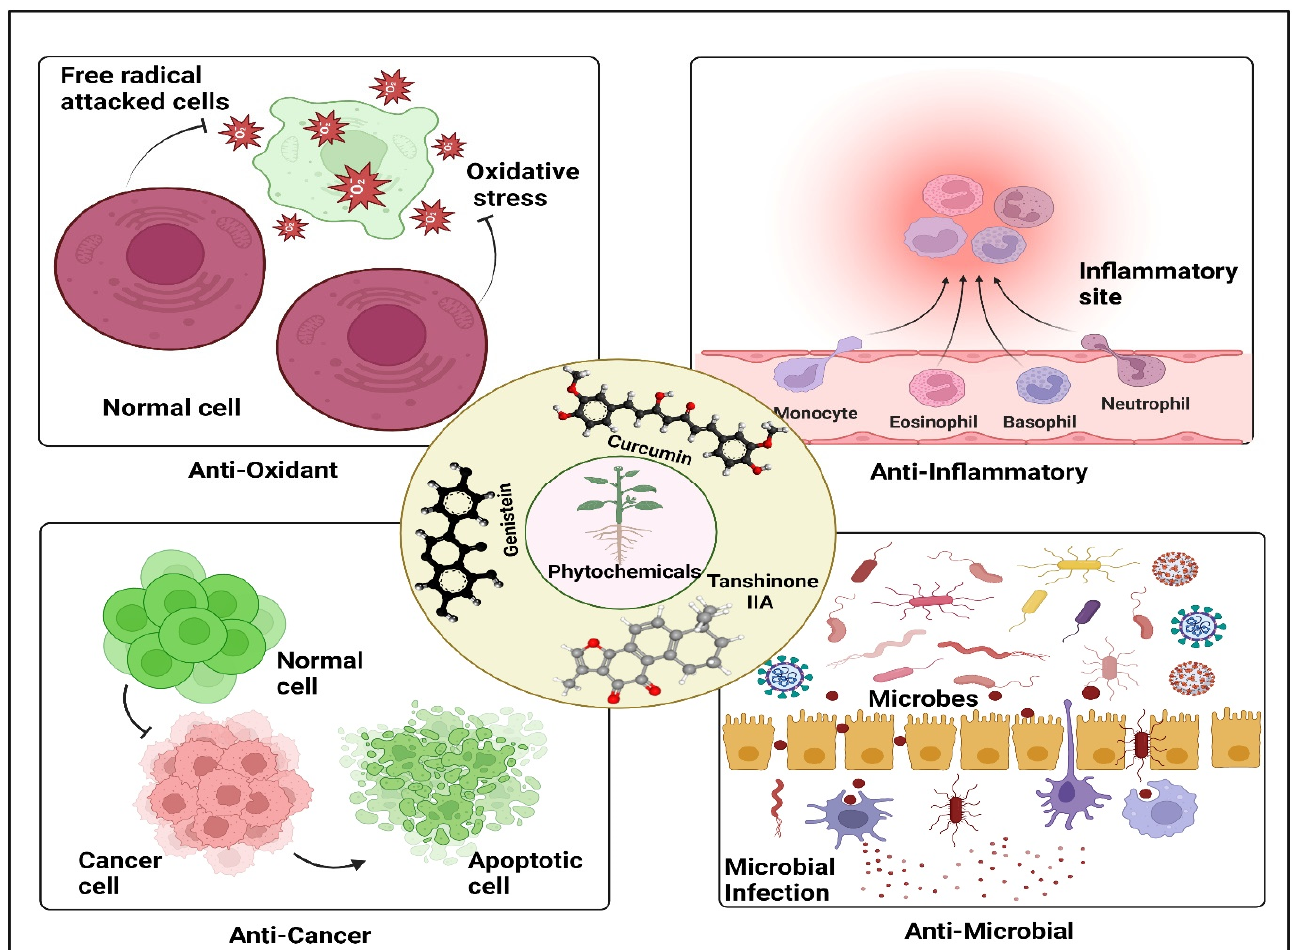
Figure 1. Representative figure highlighting some of the therapeutic potentials of curcumin, genistein, and tanshinone IIA. These phytochemicals have been shown to possess intriguing anti ‐ microbial, anti ‐ inflammatory, anti ‐ oxidant, and anti ‐ cancer potentials. The figures are prepared with the BioRender Software (biorender.com).